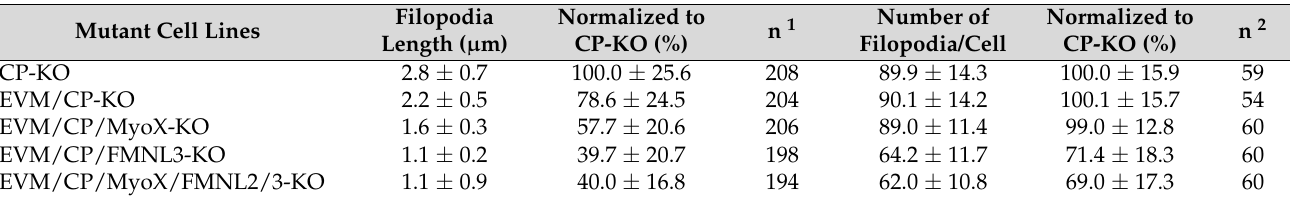
Table 1. Comparison of length and number of peripheral filopodia in analyzed mutant cell lines. Values indicate mean ± SD of pooled data from independent clones of respective genotype. n: number filopodia 1 or cells 2